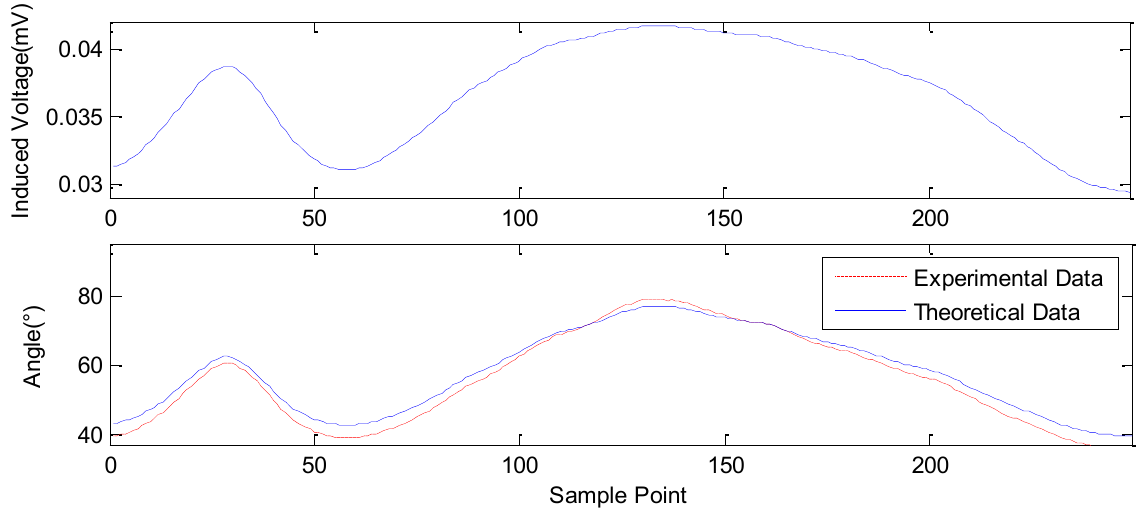
Figure 14. The sensing effect at large angle